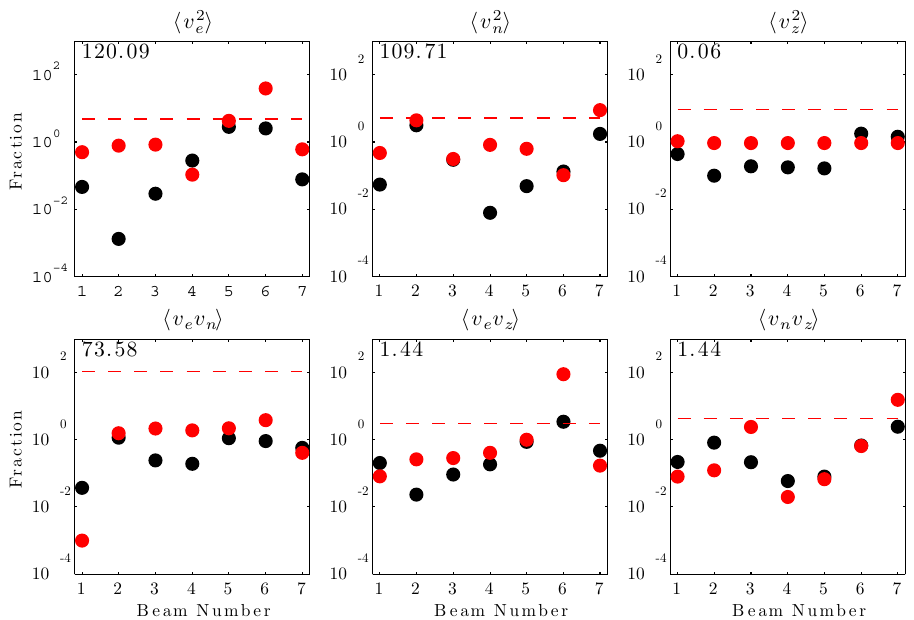
Fig. 2. Using beam map #1, estimate of the fractional increase in the variance of each estimated wind variance/covariance term after remov- ing individual beams (indicated by the x-axis) from the estimation procedure, for (black) procedure including covariance terms and (red) procedure neglecting covariance terms. This process assumes a diagonal measurement error covariance matrix. The absolute value of the variance (for a measurement error covariance matrix given by the identity matrix) using all beams is indicated in the upper left of each panel for the procedure including the covariance terms. The ratio of the absolute values using all beams is indicated by the horizontal red dashed line. This turns out to be an overestimate, due mostly to the covariance of the